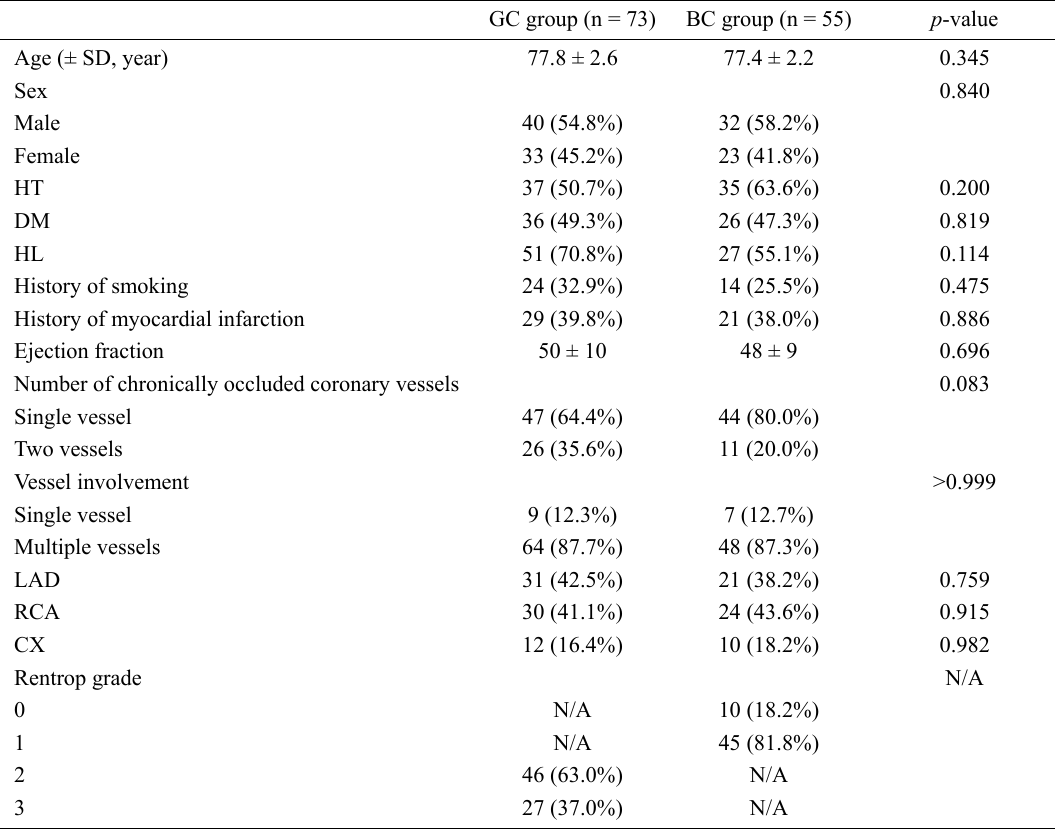
Table 1. Demographic and clinical characteristics of the patients in the good collateral (GC) and bad collateral (BC)